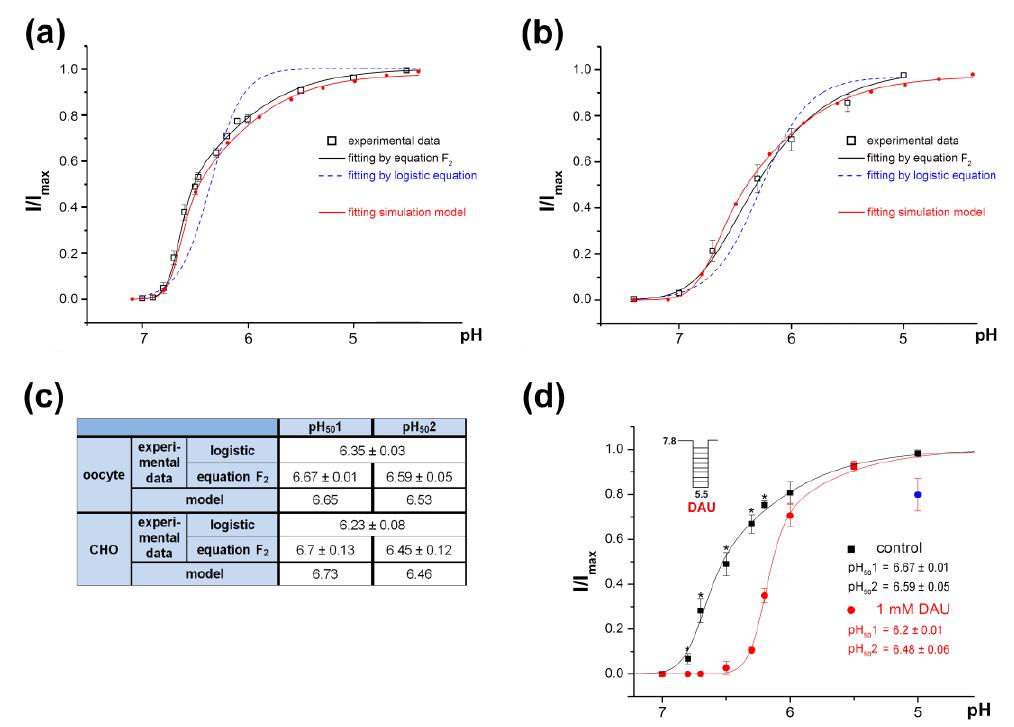
Figure 6. The peculiarity of rat ASIC1a activation by protons. ( a ) pH dependence of activation of ASIC1a channels expressed in X. laevis oocytes fitted to the logistic equation F 1 (dotted line) and to equation F 2 (black solid line). Redline reflects pH dependence of activation of model 3–10 corresponding to activation of the channel at the binding of 10 protons with coe ffi cients of cooperativity of p = r = 0.8 and q = s = 0.65, respectively, fitted to equation F 2 . ( b ) pH dependence of activation of the channels expressed in CHO cells fitted to the logistic equation F 1 (dashed line) and to equation F 2 (black solid line). The data were re-plotted from Figure 1k in [38]. Redline reflects pH dependence of activation of model 3–10 corresponding to activation of the channel at the binding of 10 protons with coe ffi cients of cooperativity of p = r = 0.79 and q = s = 0.6, respectively, fitted to equation F 2 . ( c ) Calculated parameters of pH 50 for non-discriminated sites, pH 50 1 for “high-cooperative” sites and pH 50 2 for “non-cooperative” site are shown as a result of experimental data mathematical processing. ( d ) pH dependence of ASIC1a activation by protons (black line) and by the combination of protons and 1 mM DAU (red line). ASIC1a held at pH 7.8 was activated by various acidic pH stimuli. I / I max is the amplitude of the peak current evoked by acidic pH stimuli and normalized to the maximum amplitude (I max ), which we calculated for each cell via individual fitting. Data are presented as mean ± SEM (n = 7); * P < 0.05.